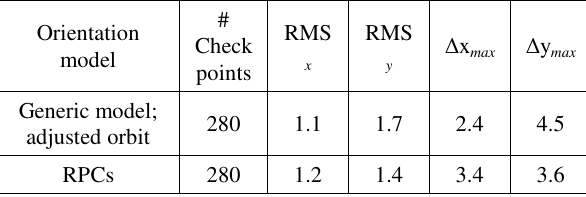
Table 2. RMS values of checkpoint discrepancies ∆ E and ∆ N